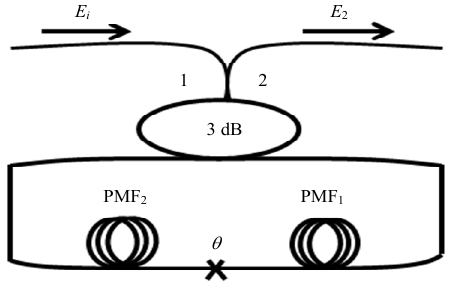
Fig. 1 Experimental schematic